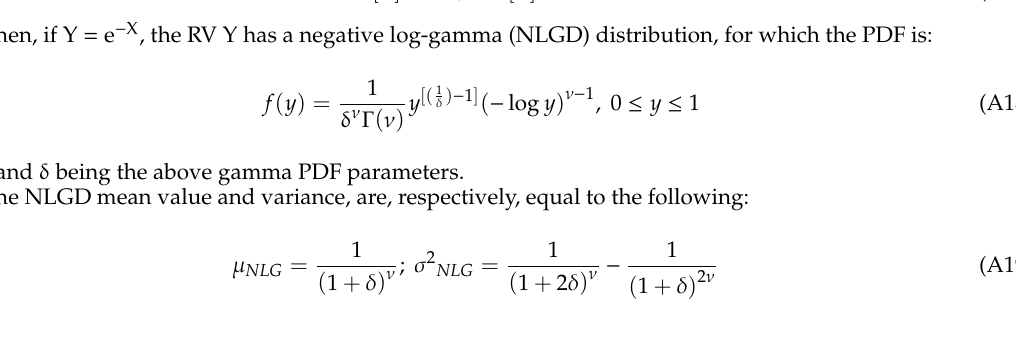
Figure A1. Weibull probability plot for the data Y k = 1/ Z k (k = 1, ...52), with Z k being the EWS data of